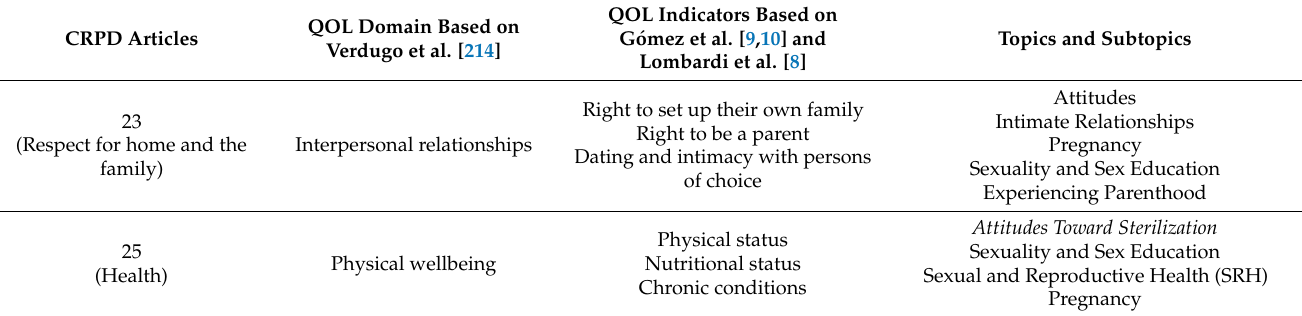
Table 4. Relationship between Articles 23 and 25, QOL domains, and the review’s main themes.